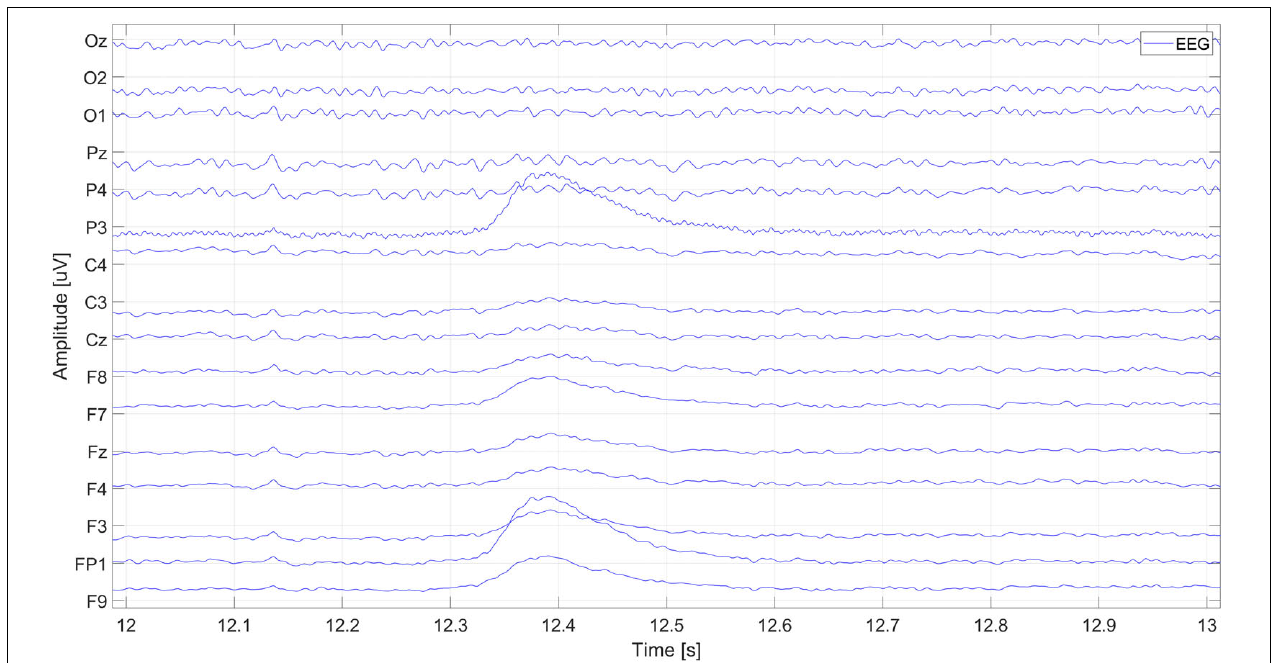
FIGURE 4 | The EEG signal fragment containing the occurrence of an eye blink